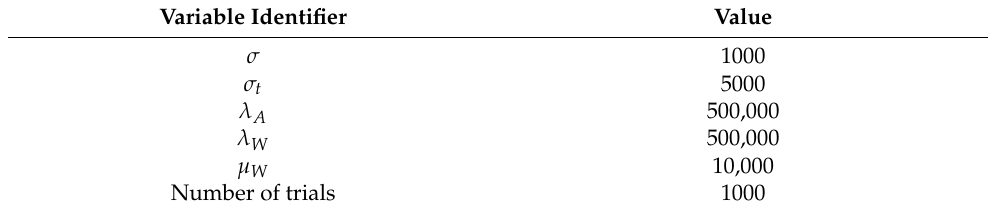
Table 3. Parameter